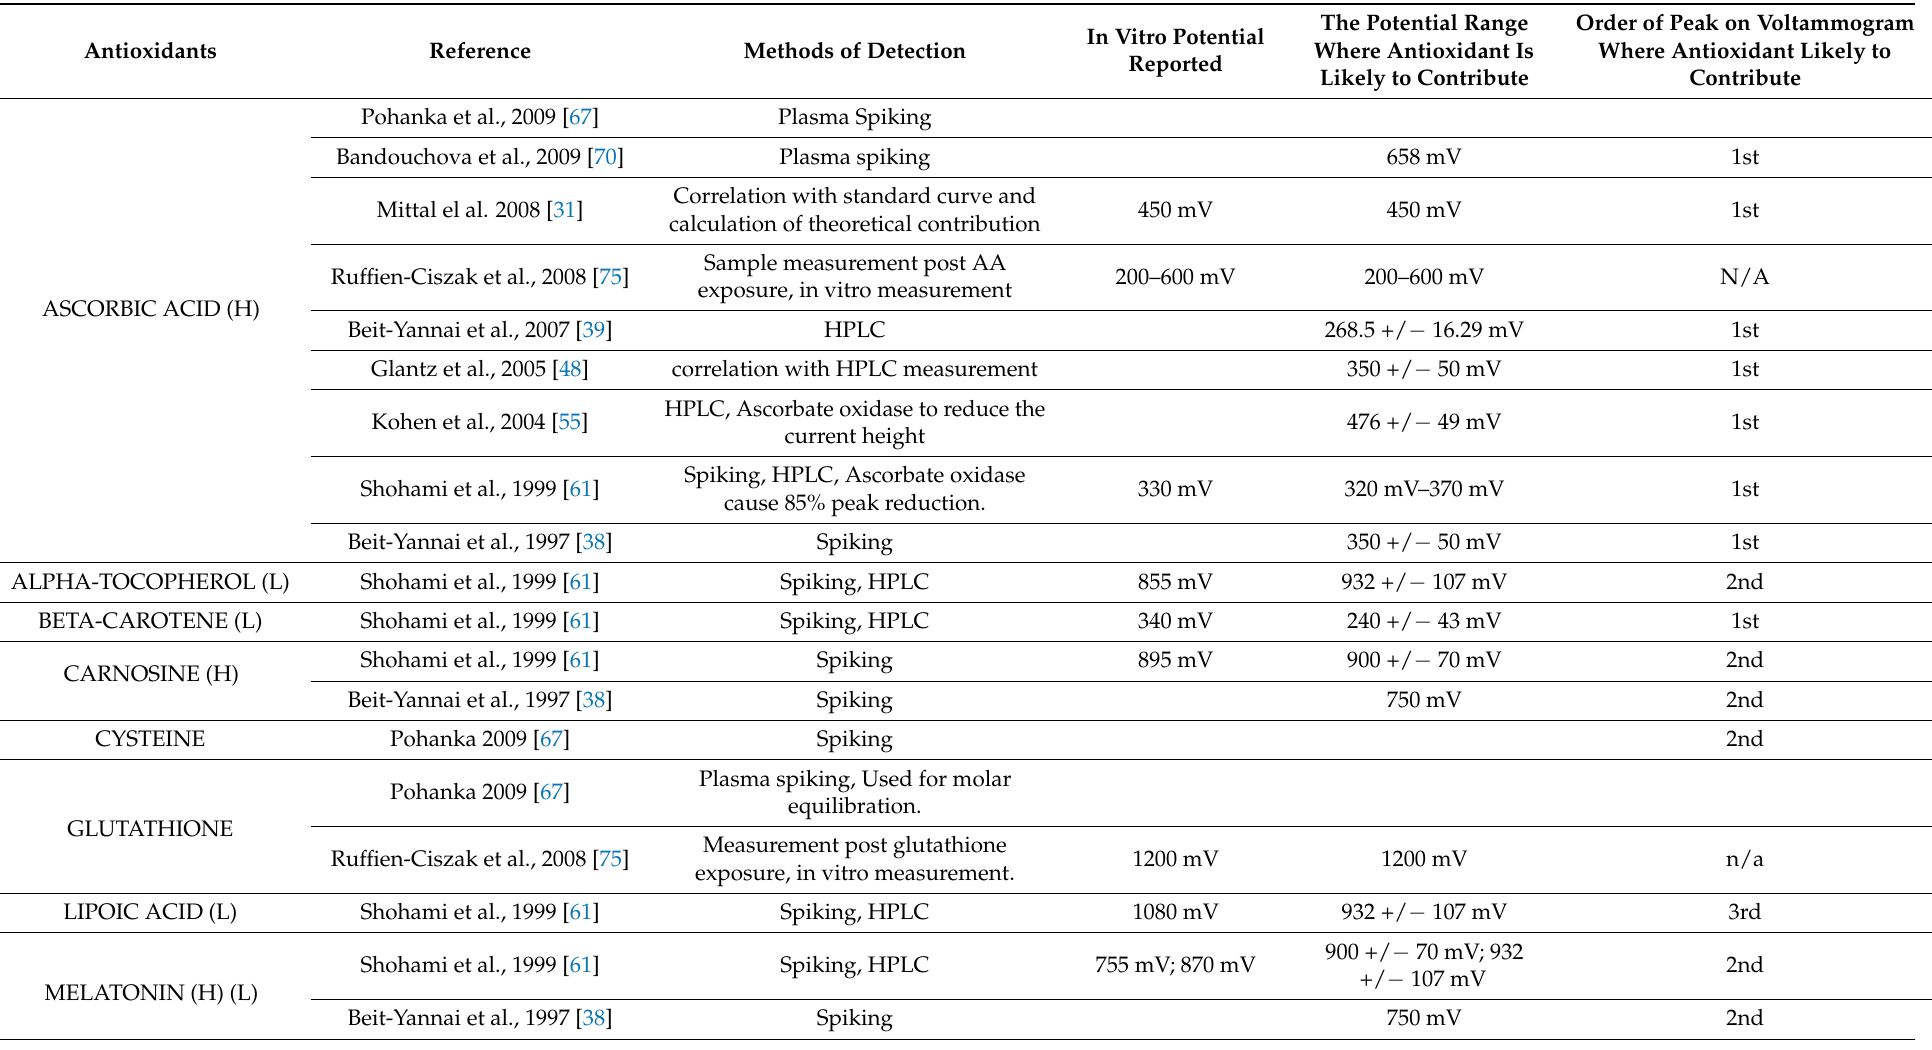
Table 2. Suggested antioxidant composition anodic peaks and method of